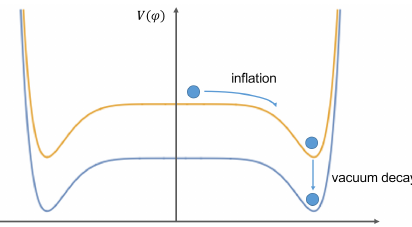
Figure 2. Landscape structure for plateau like potentials. The potential energy of the plateau can be large enough to trigger inflation for a high value of the mode n . Afterwards, the universe may undergo a series of vacuum decays